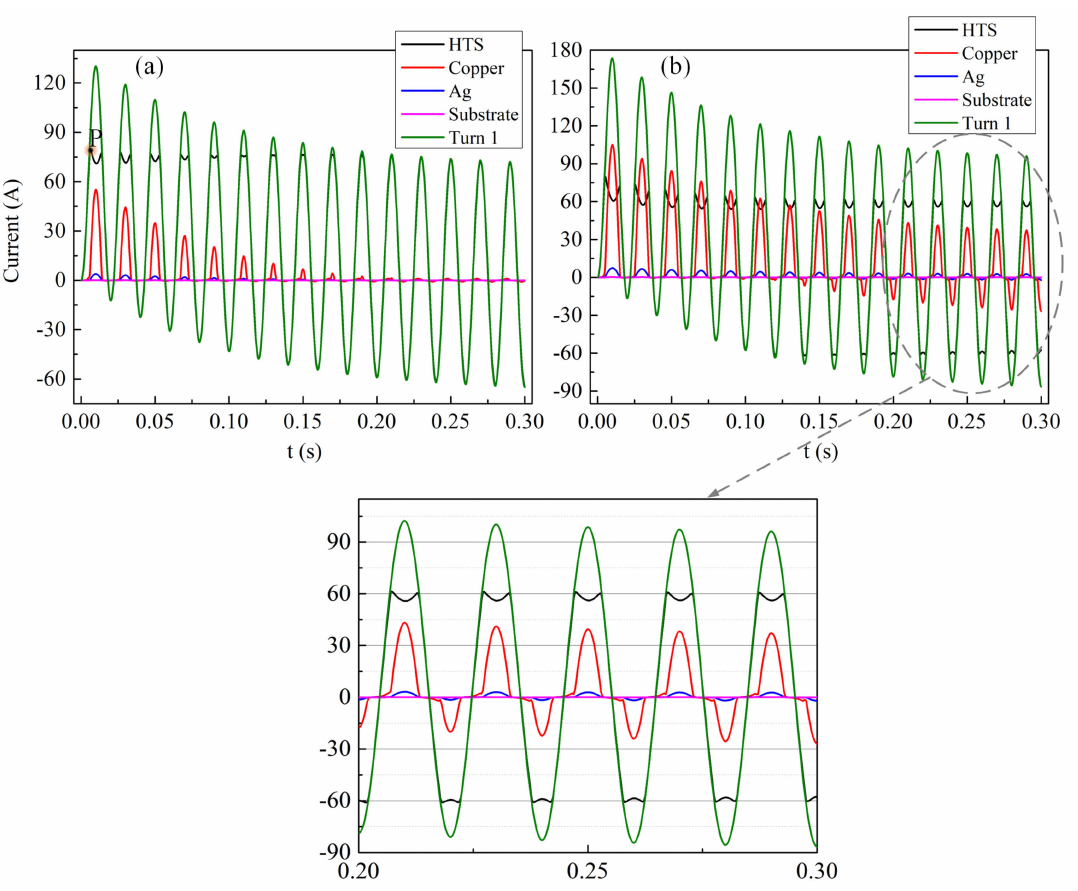
Figure 4. The current distribution in different layers of the first turn in the REBCO coil changes with time under different fault currents (( a ) I p = 0.6 I c0 , ( b ) I p = 0.8 I c0